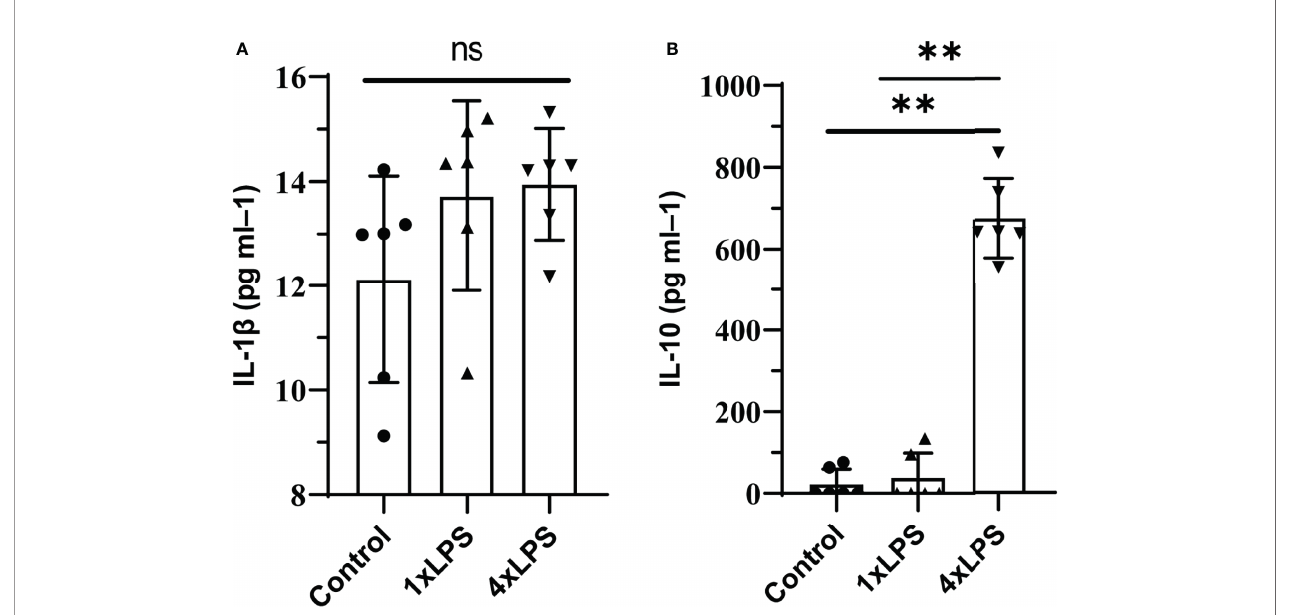
FIGURE 1 | Peripheral cytokine levels in C57BL/6 mice following lipopolysaccharide (LPS) injections. Note that tolerance is induced with repeated injections. IL-1 b was detected on day 4, no differences were found. tolerance occurs after immune tolerance (4×LPS). (A) There was no signi fi cant difference in serum in fl ammatory factor IL-1 b among the three groups. (B) The level of IL-10 in the immunotolerant group (4 x LPS) was signi fi cantly increased. ns, no signi fi cance. **P < 0.01 by one- way ANOVA (and nonparametric or mixed) followed by methods of multiple